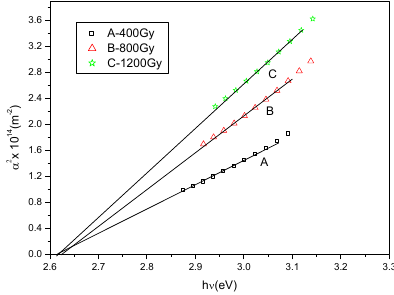
FePc thin γ-radiation 16